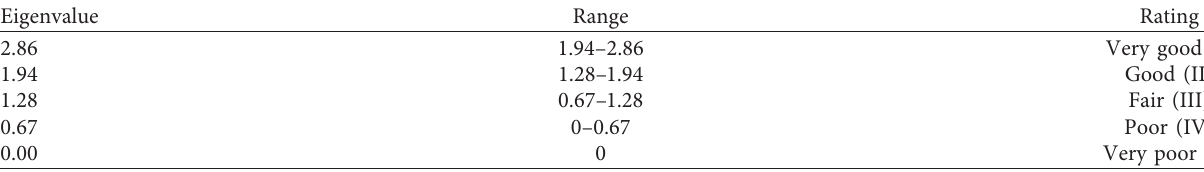
Table 16: Rating of tunnel contour quality.